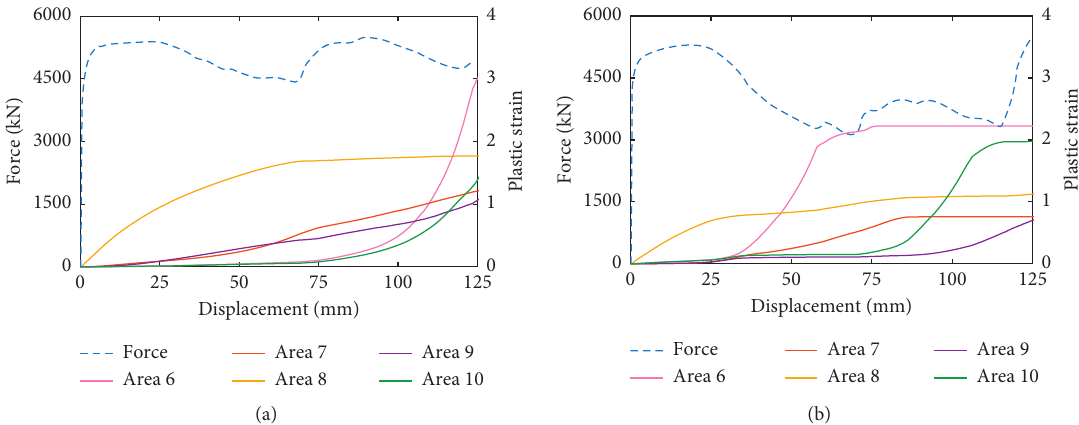
Figure 14: Displacement curve of load and plastic strain of each analysis area on the concave side of the device (a) before thickened and (b) after thickened. Table 2: Variance of the load-displacement curve of the energy absorption device with a different friction coefficient.